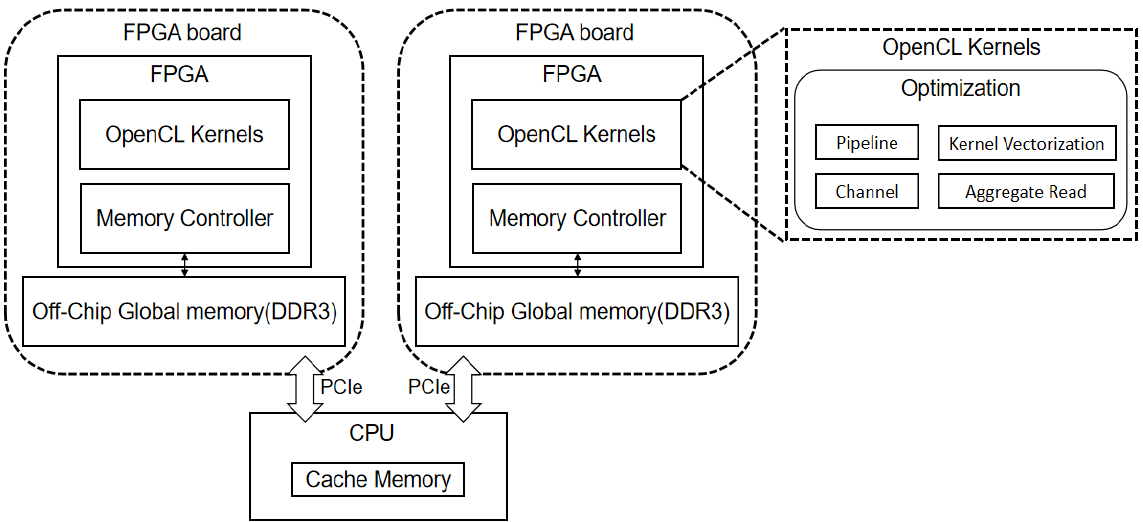
Figure 4. Model parallel computing architecture.